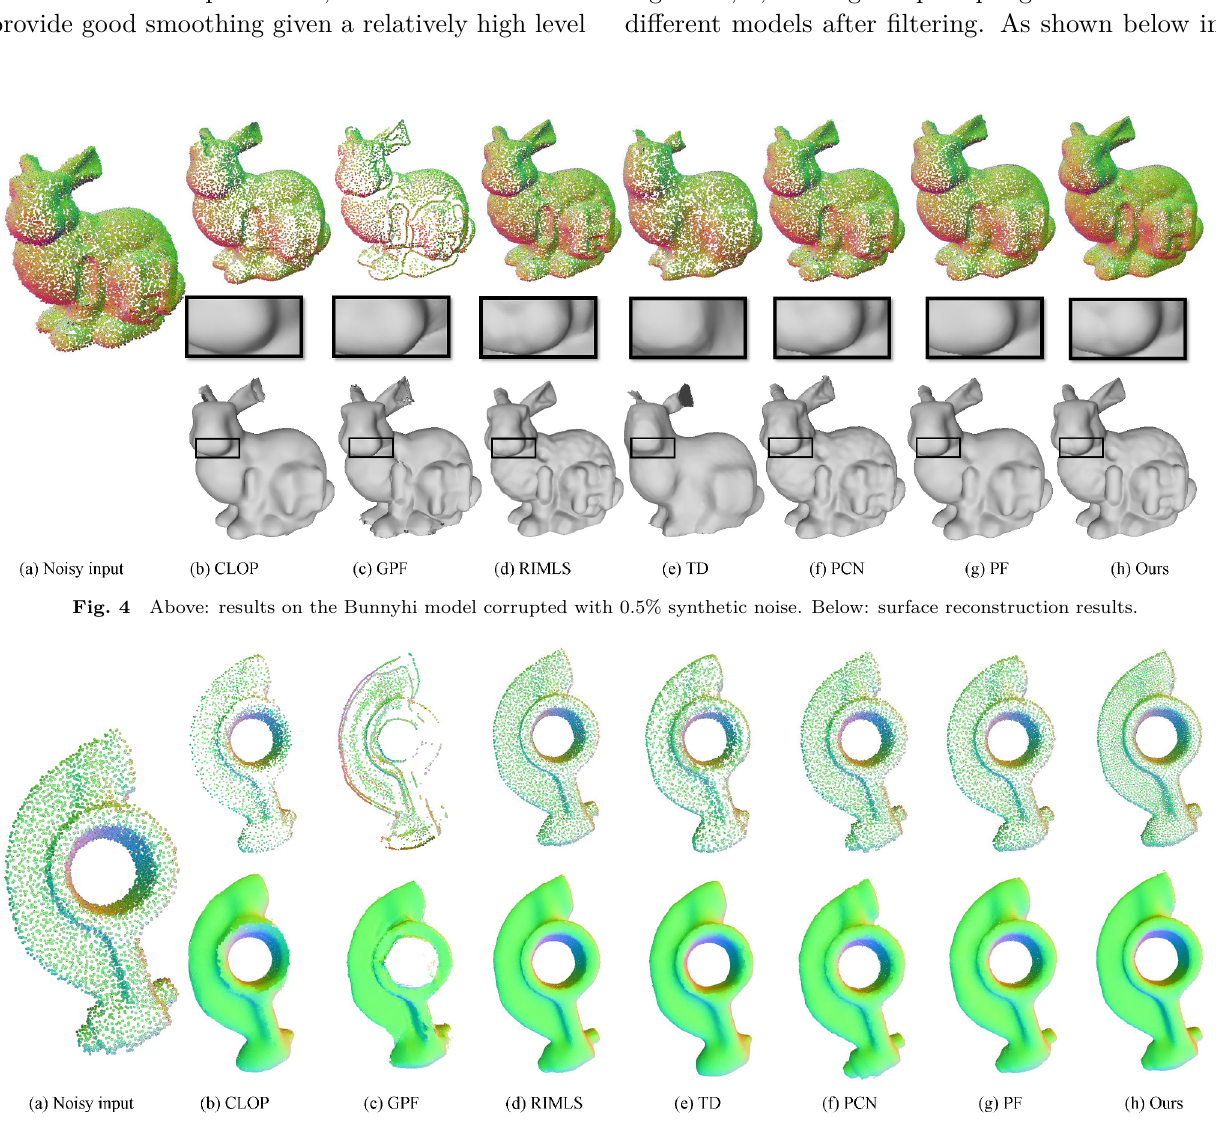
Fig. 5 Above: results on Rockerarm corrupted with 0.5% synthetic noise. Below: corresponding upsampling